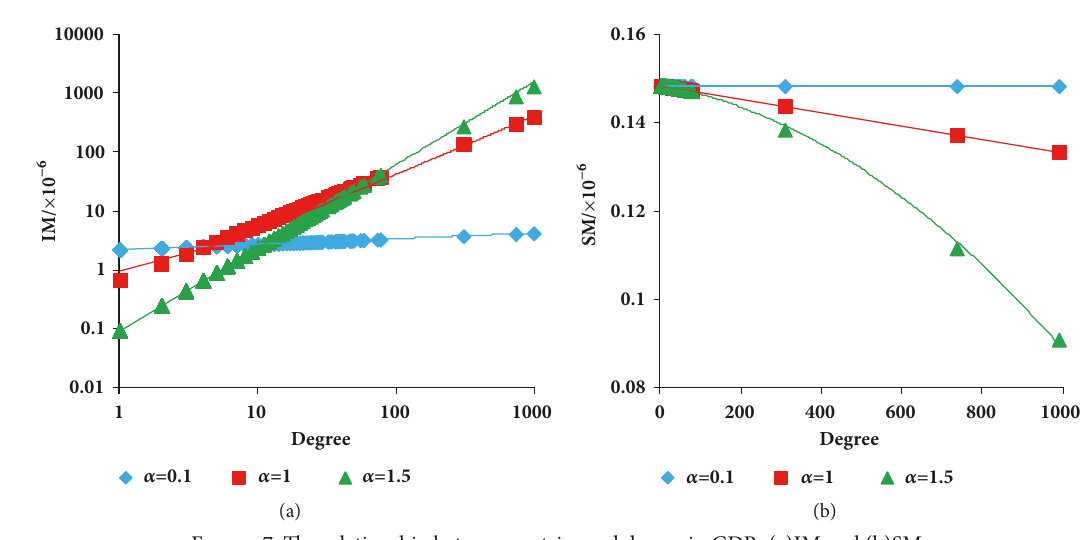
Figure 7: The relationship between metrics and degree in GDR. (a)IM and (b)SM.